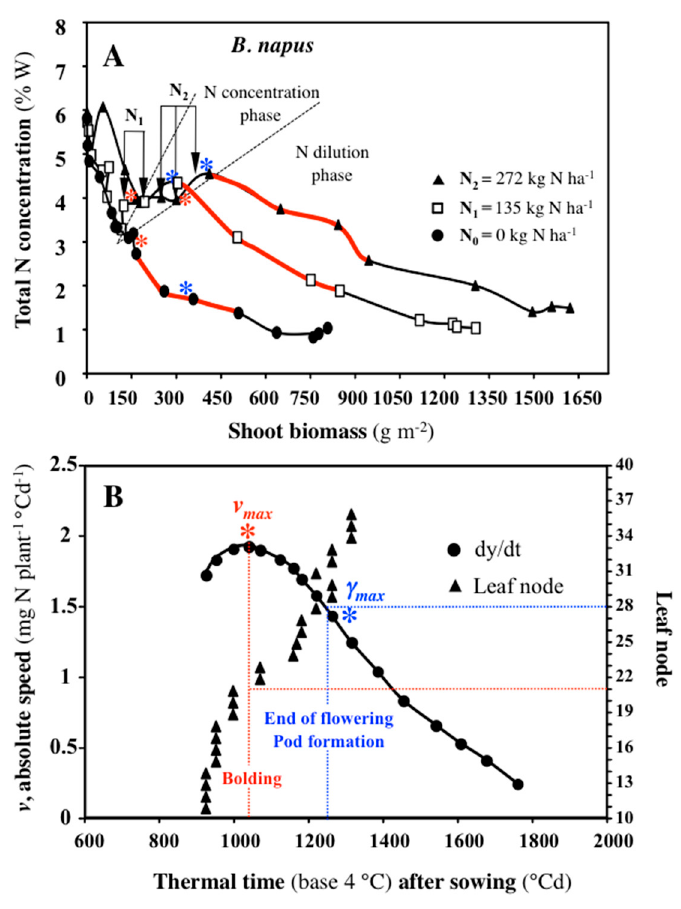
Figure 3. ( A ) Dilution curves of Brassica napus (cultivar ' Göeland') plants for three levels of fertilization (adapted from [15]). Arrows indicate the dates of fertilizer applications for N1 and N2 treatments. Red asterisks indicate the maximum absolute speed of N uptake. Blue asterisks indicate the maximum deceleration rate for each nitrogen fertilizer treatment. Red lines represent the N dilution phase from the bolting period to flowering. ( B ) Relationship between the maximum absolute speed ( v max and γ max ) of the N uptake rate and the beginning of N remobilization (date in thermal time) of a specific leaf node in Brassica napus (cultivar ' Capitol', adapted from [26]).